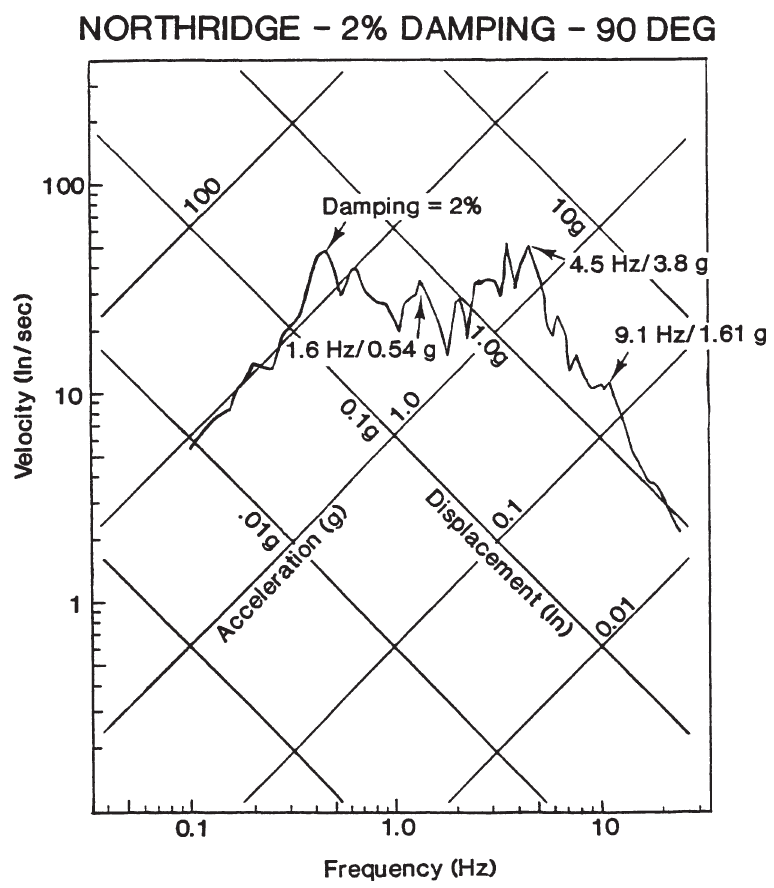
Fig. 2. Quadra-log plot for the response at 2% damping at Santa Monica station during the 1994 Northridge